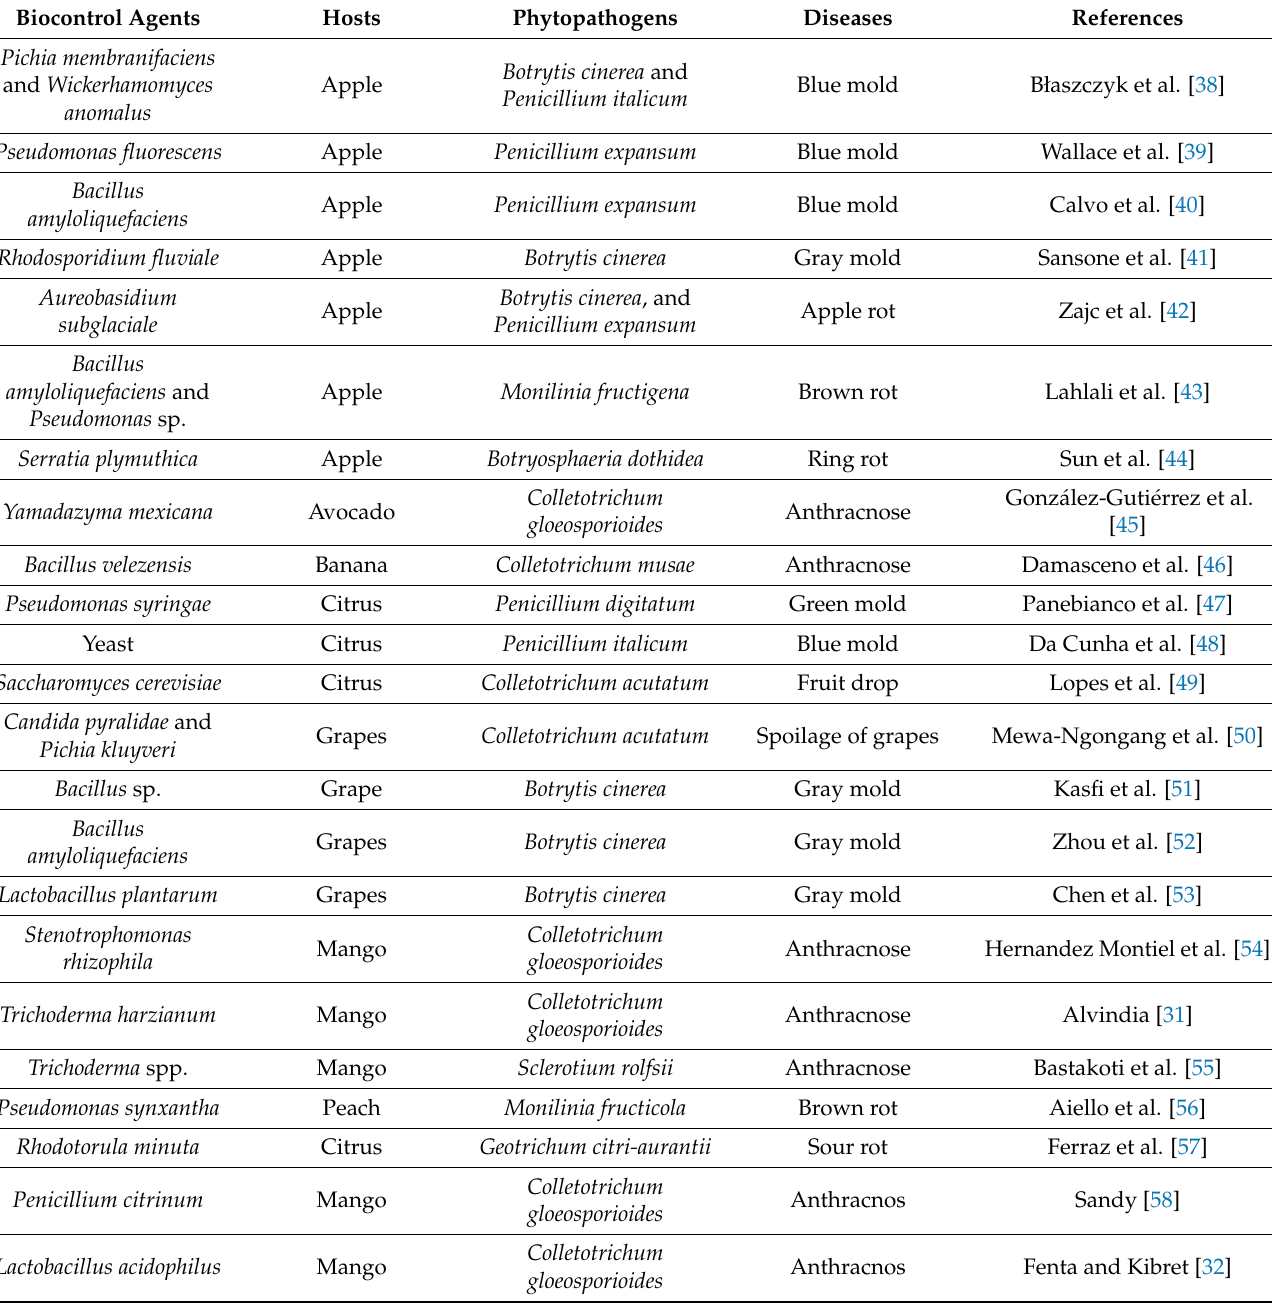
Table 1. Microbial antagonists recovered from various sources and used as biocontrol agents for postharvest plant